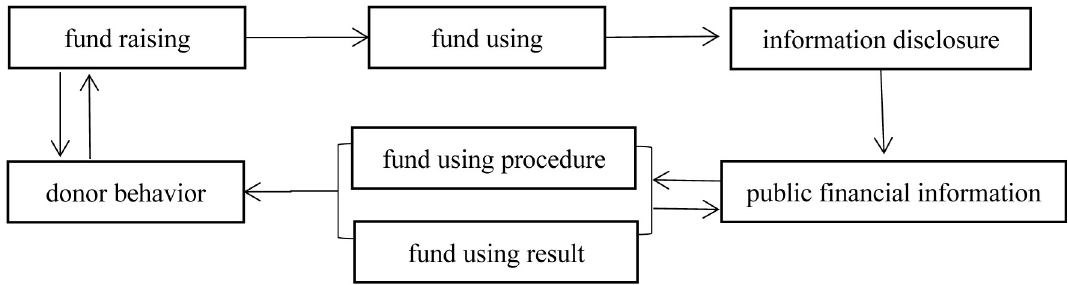
Fig 3. The relationship of financial activities and donor behavior of